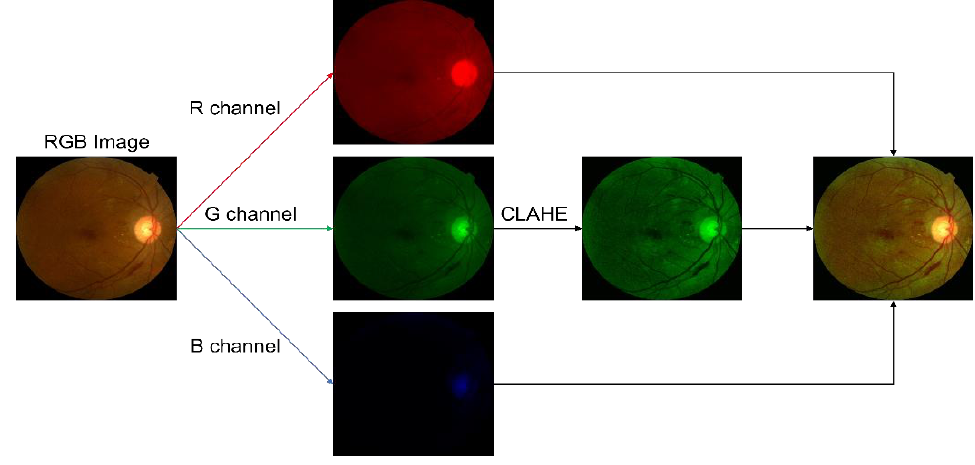
Figure 5. Pre-processing technique.